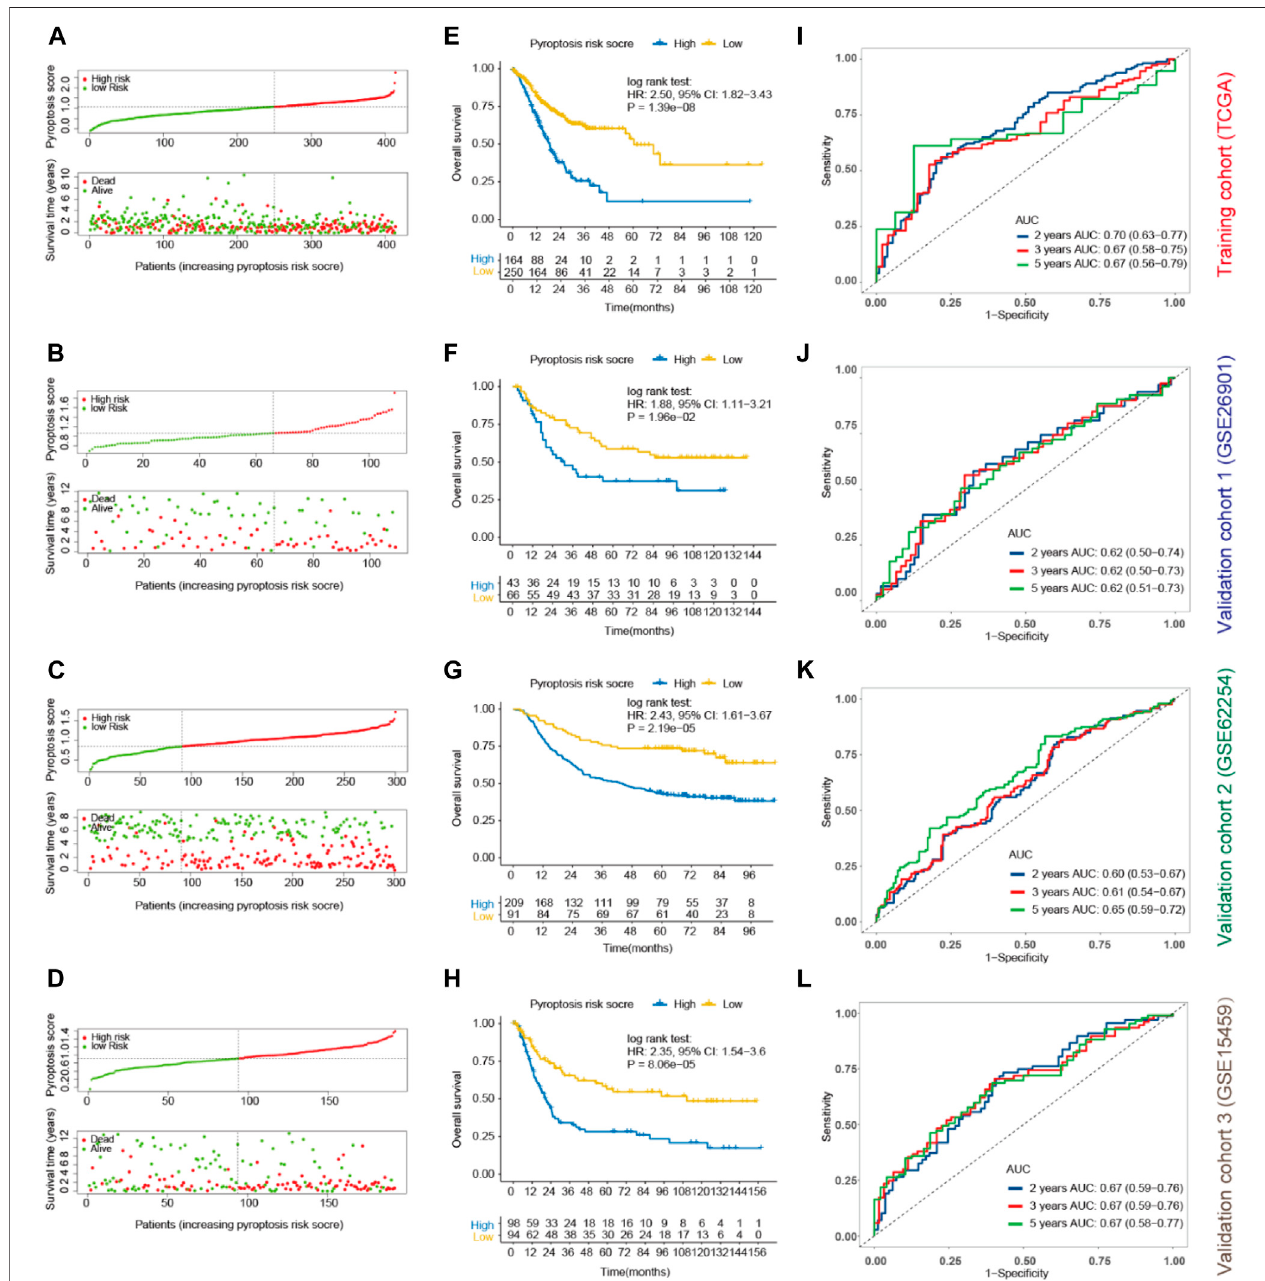
FIGURE4 | Prognostic values ofpyroptosis riskscore for OSin gastric cancer. Patients were divided into high- and low-pyroptosisriskscore groups according to the optimal cutoff value using “ survminer ” package in the training (TCGA; (A) , validation cohort-1 (GSE26901; (B) , validation cohort- 2 (GSE62254; (C) and validation cohort-3(GSE15459; (D) .Kaplan-MeiercurvesofOSofthehigh-andlow-pyroptosisriskscoregroupsinthetraining (E) ,validation cohort-1 (F) ,validationcohort-2 (G) and validation cohort-3 (H) . Time-dependent ROC for 2, 3, 5 years based on pyroptosis risk score in the training (I) , validation cohort-1 (J) , validation cohort-2 (K) and validation cohort-3 (L) cohorts. OS, overall survival; ROC, receiver operating characteristics curves.